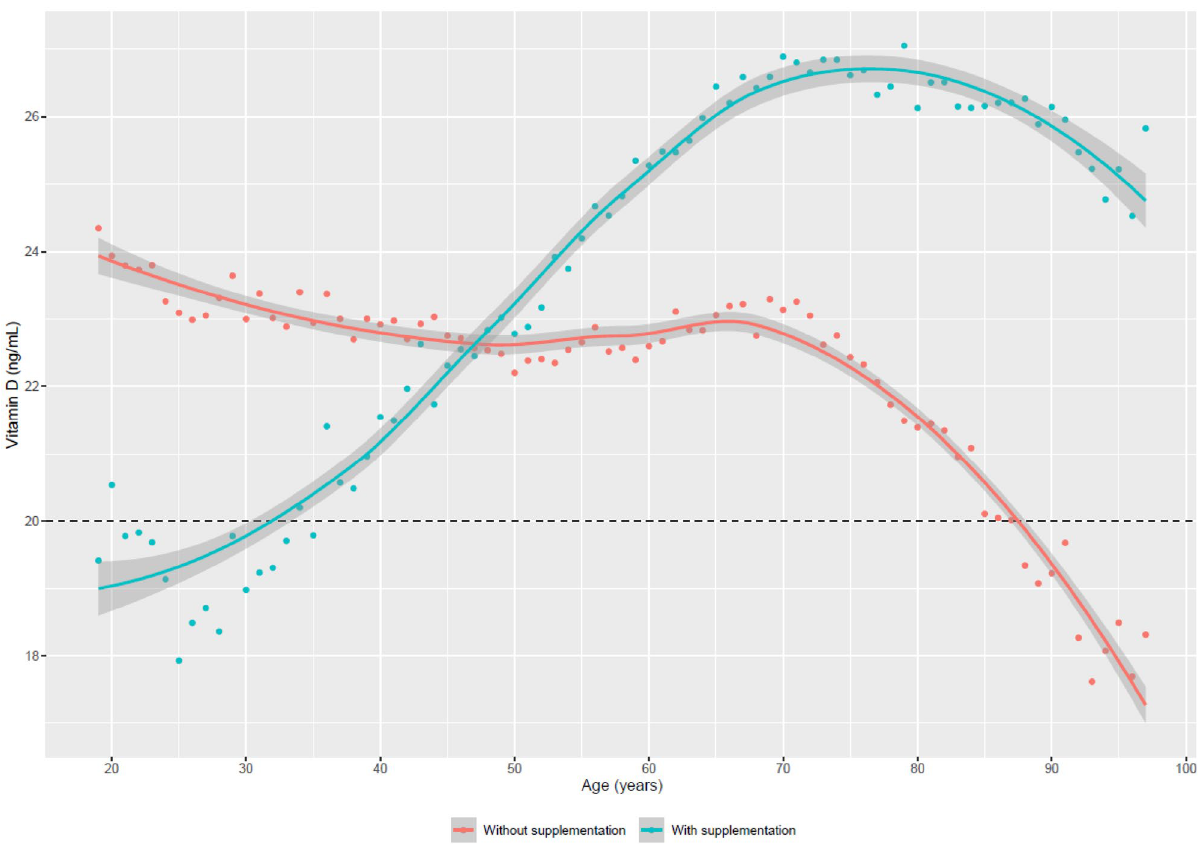
Figure 1. Vitamin D levels by age differentiated according to whether there is prescribed supplementation. The red and blue dots correspond to the averages of vitamin D in each age group without and with supplementation correspondingly. Smooth curves in red and blue color (with 95% confidence intervals) represent the association between age and vitamin D.